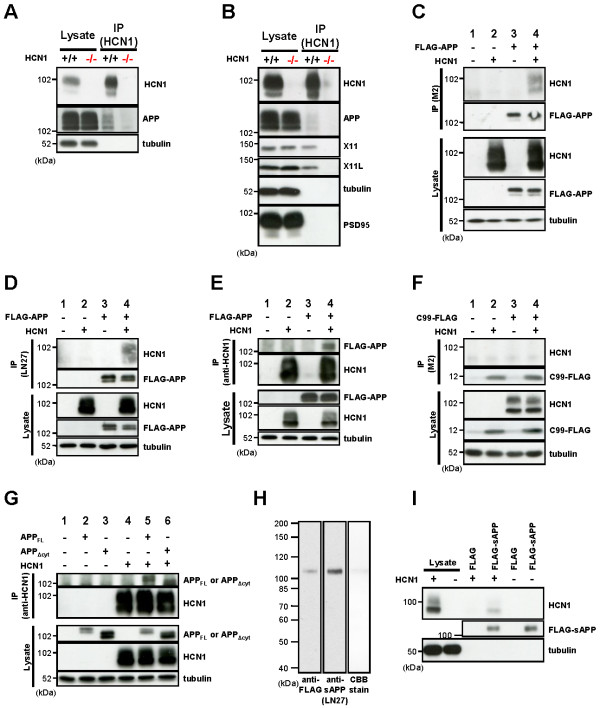
APP and HCN1 form a molecular complex in vivo and in vitro. (A) Co-immunoprecipitation of the HCN1-APP complex from the wild type and HCN1-/-murine cortex. Brain lysates were immunoprecipitated with an anti-HCN1 antibody. Immunocomplexes were detected by immunoblotting. (B) Co-immunoprecipitation of HCN1-APP, -X11 and -X11L complexes from the EC-rich cortex (see Additional file 1: Figure S2). Brain lysates were immunoprecipitated with an anti-HCN1 antibody. Immunocomplexes were detected by immunoblotting. (C–G) Co-immunoprecipitation of the HCN1-APP complex from N2a cells transiently overexpressing FLAG-APP and murine HCN1. (C–E), Analysis of FLAG-APP and murine HCN1, (F) C99-FLAG and murine HCN1, and (G) APPFL or APPΔcyt and murine HCN1 immunocomplexes. To standardize the amount of plasmid, empty vector (−) was added to yield 1.2 μg of plasmid in total. Cell lysates were immunoprecipitated with anti-FLAG M2 (C and F), anti-APP extracellular domain (LN27) (D), or anti-HCN1 (E and G) antibodies. Immunocomplexes were detected by immunoblotting. (H) Affinity purification of FLAG-sAPP secreted into the culture medium by N2a cells expressing FLAG-APP. The purification was performed using anti-FLAG M2 affinity beads. FLAG-sAPP were specifically detected by M2 and anti-APP extracellular domain (LN27) antibodies, and no contaminating bands were identified by CBB-staining. (I) Pull-down of HCN1 with affinity purified FLAG-sAPP prepared in (H). Lysates from wild type cells (−) and cells that transiently expressed HCN1 (+) were incubated with M2 affinity beads coupled with FLAG-tag or FLAG-sAPP. The complexes resulting from the pull-down assay were subjected to immunoblot analysis with anti-HCN1 antibody.